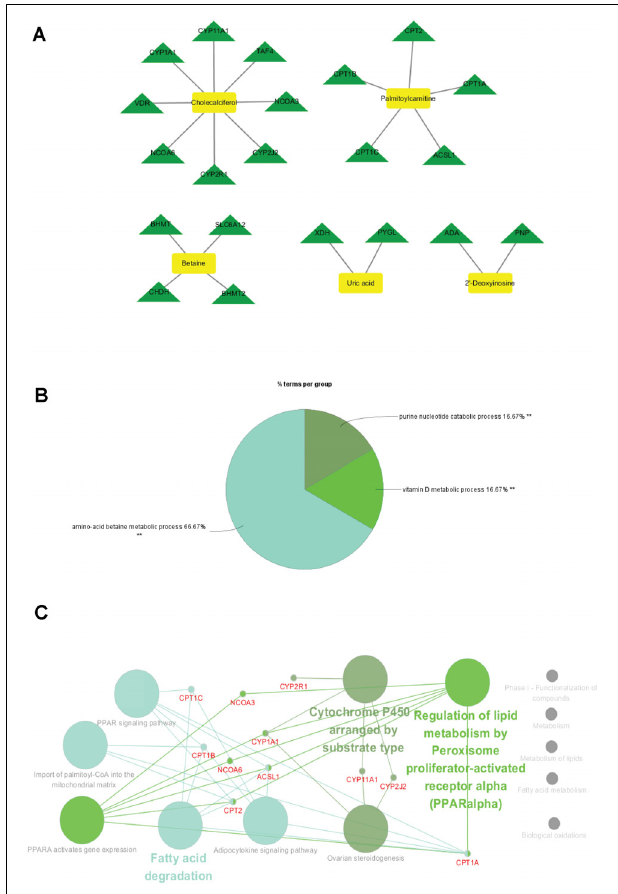
FIGURE 8 | Metabolite-related proteins identified from the database and their associated analysis were visualized by the Cytoscape tool. (A) Representative metabolite–protein interaction network of the cortex, extracted from the database during the subacute phase. The network was constructed with metabolite compounds (yellow and rectangle) and protein enzymes (green and triangle) as nodes. (B) A pie chart provides a visualization of the three biological processes enriched by the proteins. (C) The protein pathway network provides a view of the functional relationships among